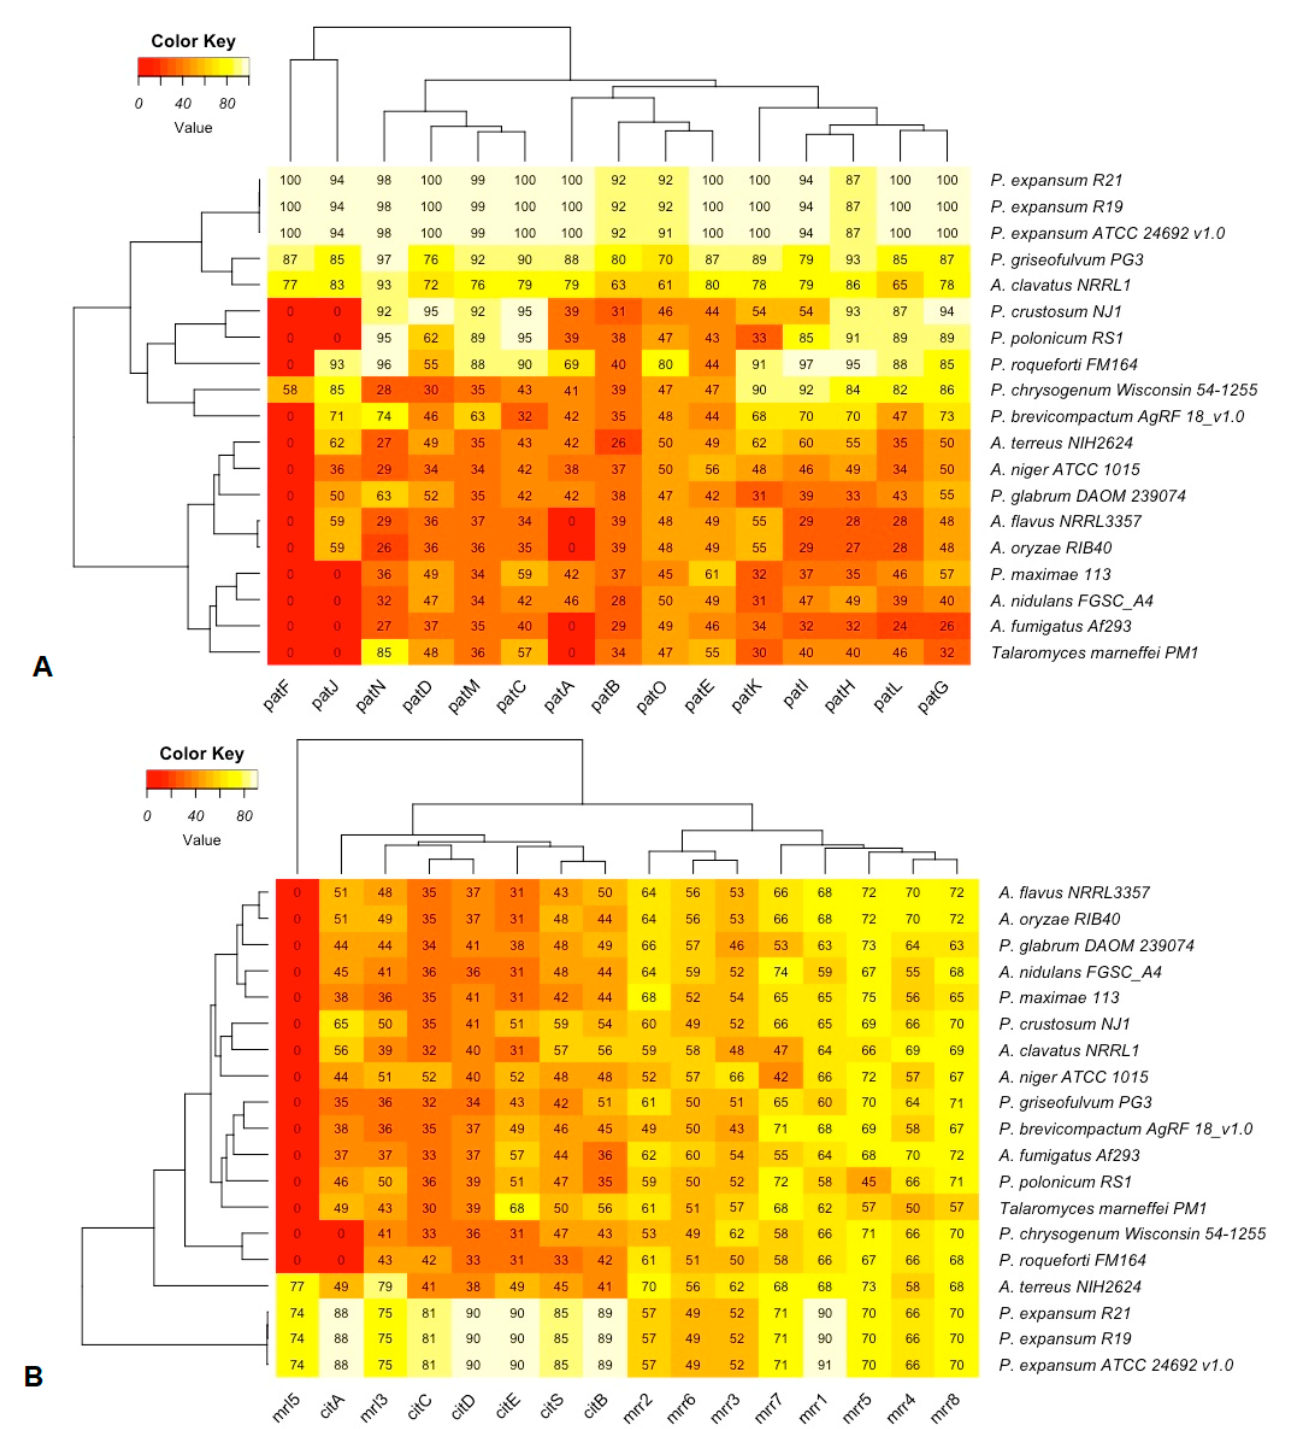
Figure 4. Functional conservation of patulin ( A ) and citrinin ( B ) gene clusters are estimated by TBLASTN identity analysis. Eleven Penicillium and seven Aspergillus strains were used.